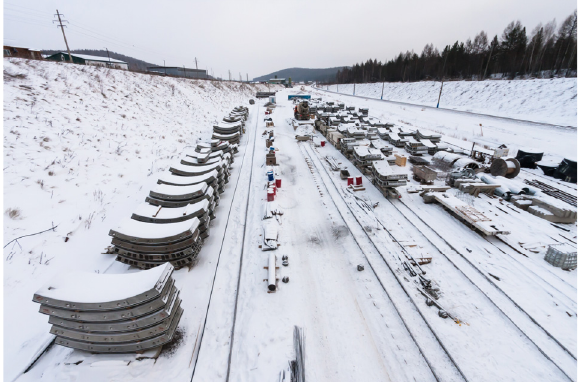
Figure 1. Precast concrete elements subjected to low temperatures (reproduced with permission from [52]).